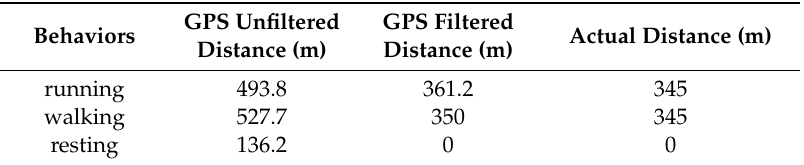
Table 4. Mean average of GPS unfiltered, GPS filtered, and actual distances for all three goat’s behavior during seven days experiment.